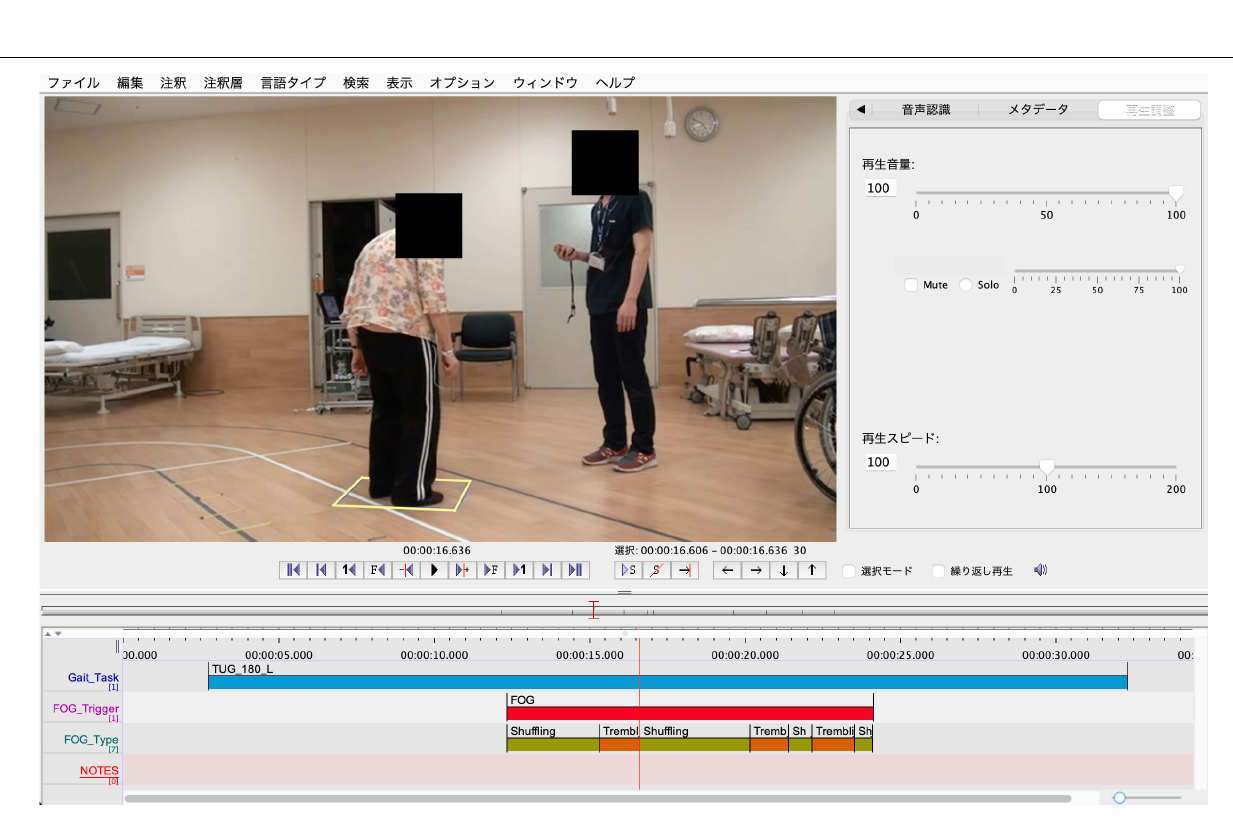
Frontiers in Human Neuroscience |